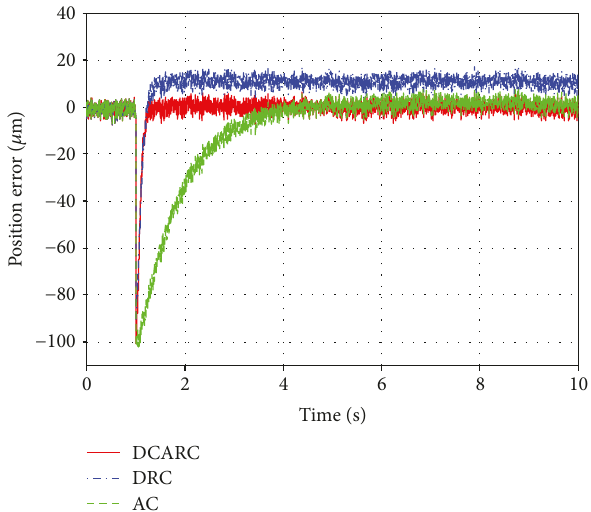
Figure 9: Measured position error of a 0.1mm step reference